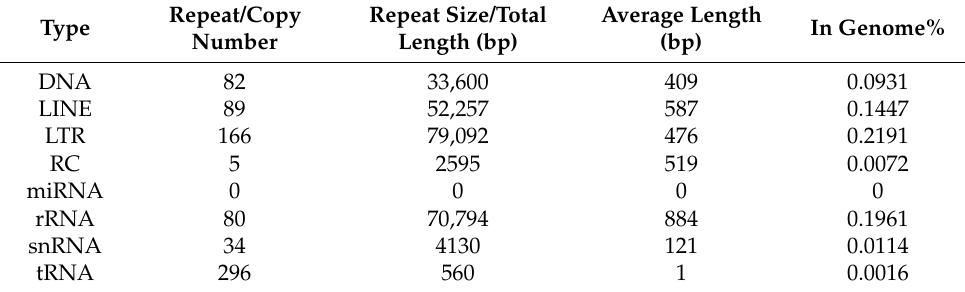
Table 2. Statistics of strain L14 assembly and annotation.